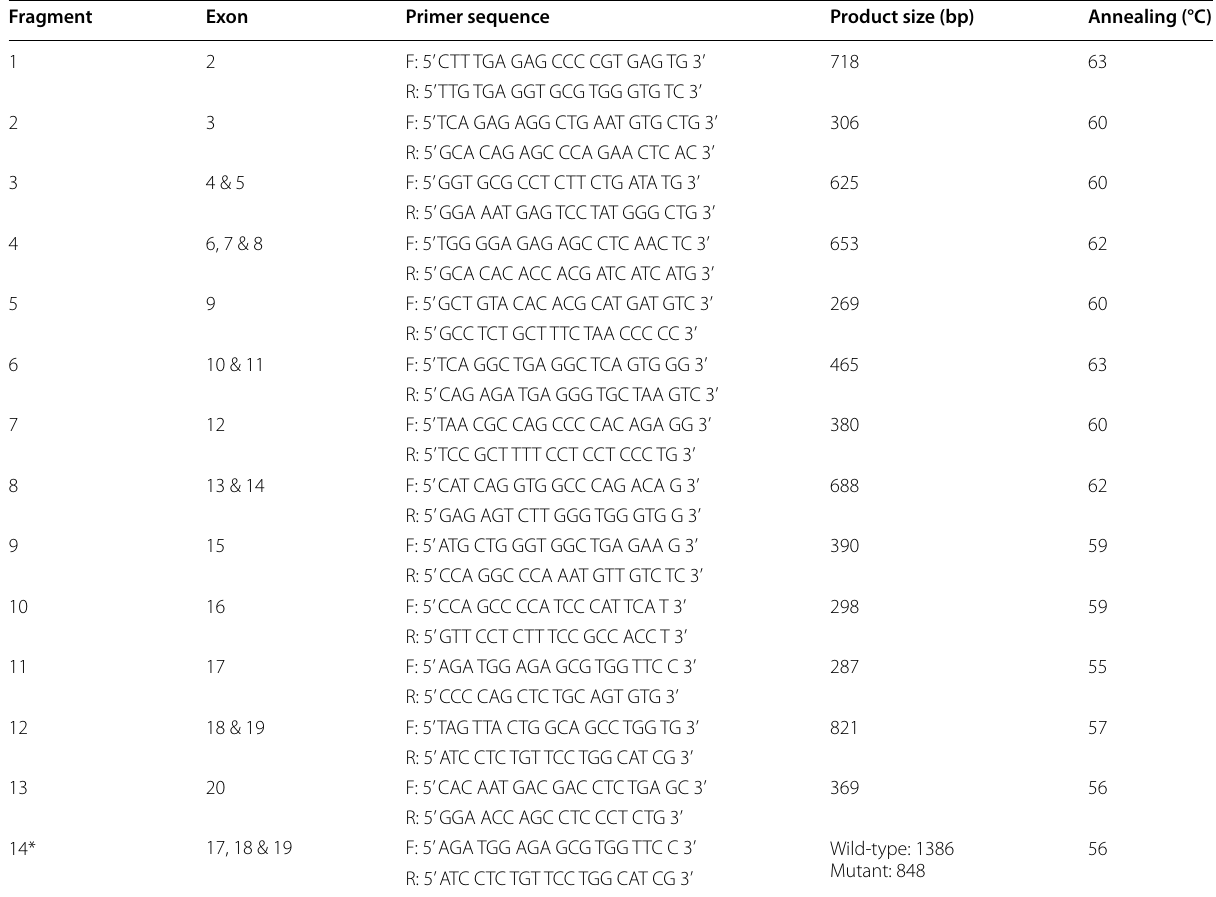
* Amplification of this fragment was carried out to investigate the entire deletion of exon 18 (538 bp)